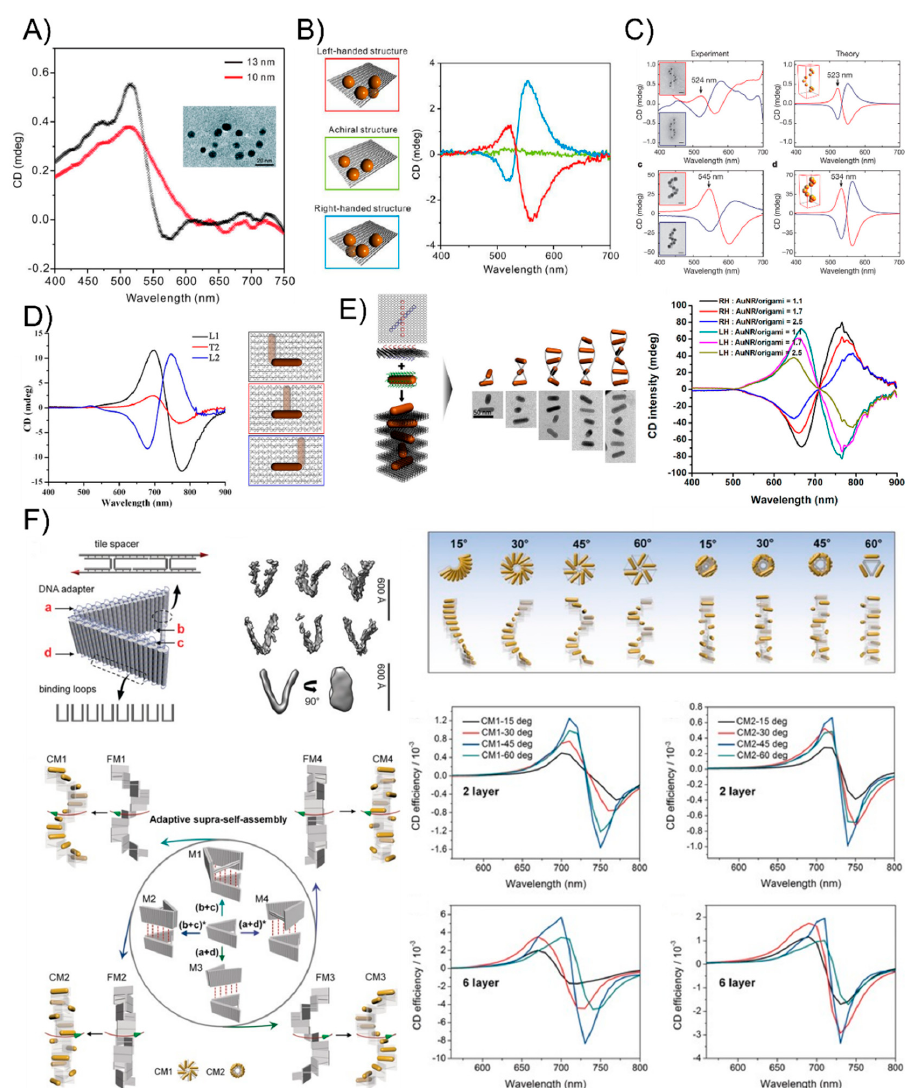
Figure 6. The plasmonic chirality of DNA-directed AuNP nanoarchitectures. ( A ) 3D plasmonic chiral nanostructures by rationally rolling and stapling AuNP-dressed rectangular origami sheets. ( B ) Left- and right-handed asymmetric tetramers present a characteristic bisignate peak-dip CD shape and a bisignate dip-peak CD profile, respectively. ( C ) The perfect assemblies of right- and left-handed helices with nine AuNRs by DNA origami 24-helix bundles show the expected plasmonic chirality. ( D ) 3D anisotropic building block nanoassemblies show a distinct plasmonic chiral response by rationally manipulating the location of the AuNRs on the origami template. ( E ) AuNRs’ helical superstructures with right and left-handedness. ( F ) An AuNR 3D chiral plasmonic helix with fully switchable chirality using a DNA-toehold-mediated conformational change. Reproduced with permission from Reference [71]. Copyright American Chemical Society, 2012; Reproduced with